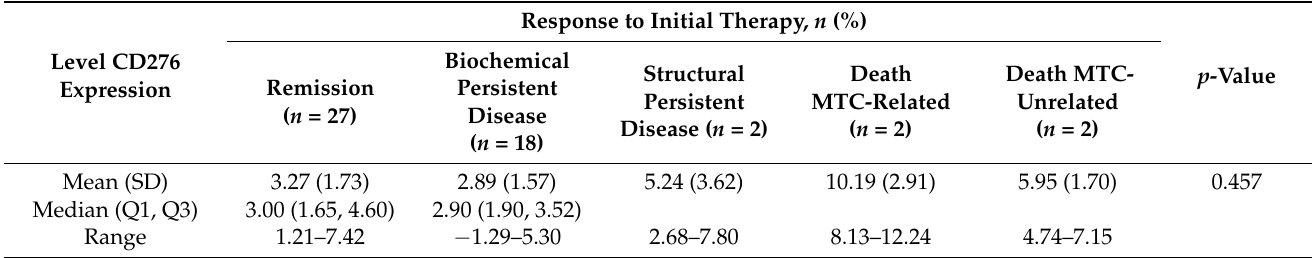
Table 4. Relationship between CD276 expression and response to initial therapy.